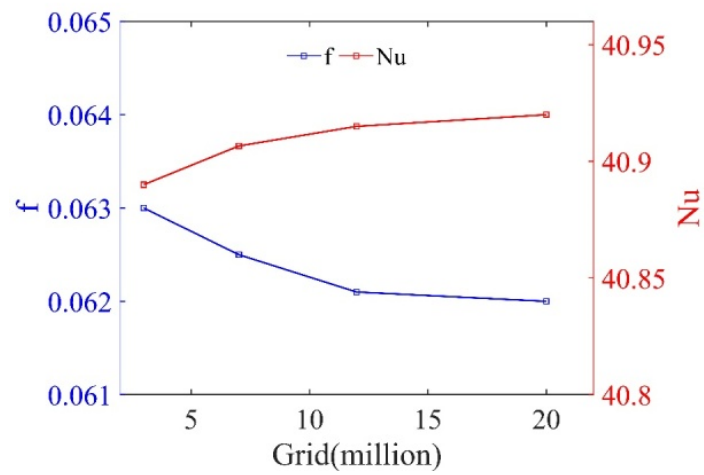
Figure 5. Grid independence test of 𝑃𝑅 = 1.5, 𝑅𝐴 = 30°.